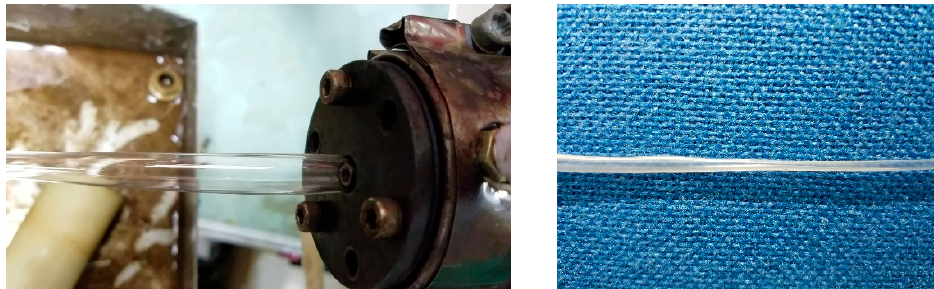
Figure 15. Micro-tube formation under 10,000 Pa.